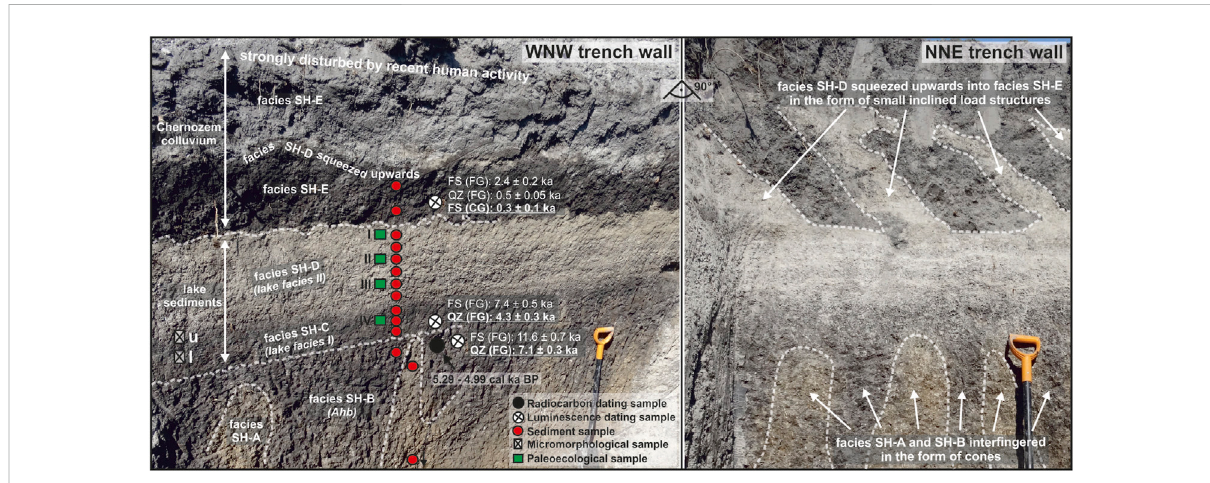
FIGURE 4 The stratigraphy of the trench with the locations of numerical dating, sediment, paleoecological and micromorphological samples. The luminescenceresults are given for feldspar (FS),quartz (QZ), fi negrain (FG)and coarse grain(CG), and thepreferred agesare underlined.Please note that the uppermost part of facies SH-E in the left-hand fi gure was not wetted, so that it appears lighter than the lower part of this material. The two trenchwallsarerectangulartoeachother.Aversionofthis fi gurewithoutanylabellingsanddrawingscanbefoundinSupplementaryFigure